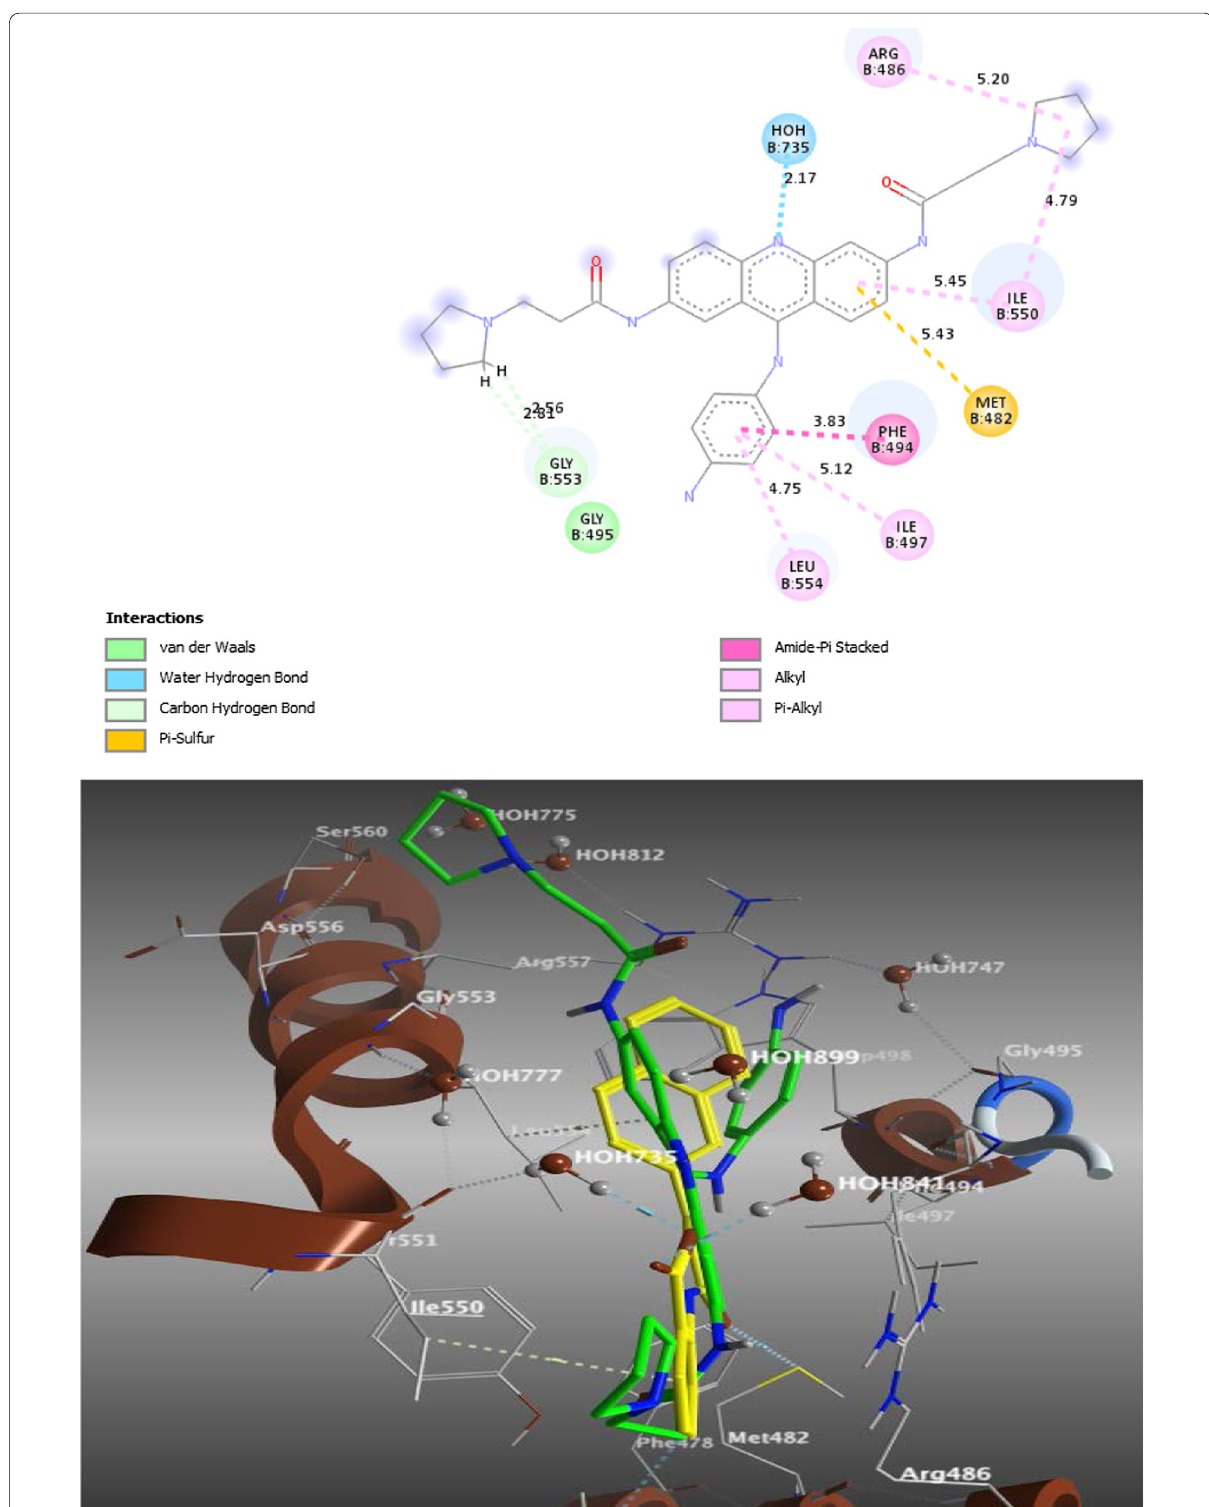
Fig. 13 Depiction of 2D interaction of pose 1 conformation of compound 82with TERT and 3D view of superimposed alignment of compound 82 (green) with crystallized ligand BIBR1532